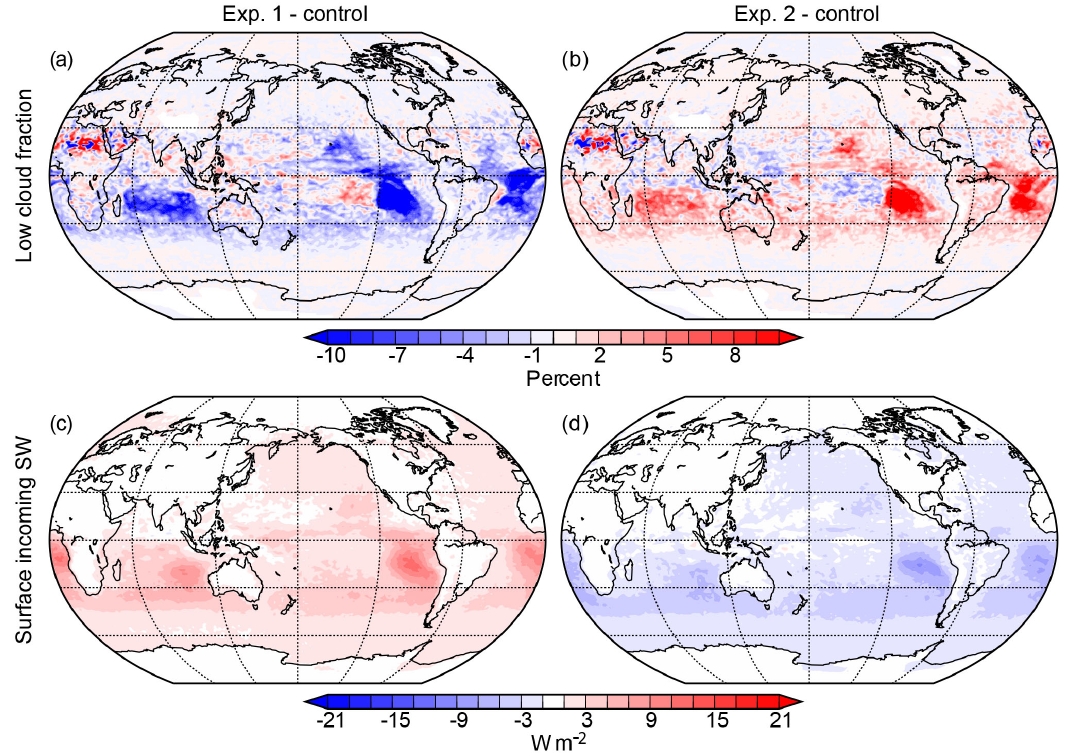
Figure 10. Comparisons of the (a–c) total liquid water at 1700m height ( Q cl ), (d–f) large-scale rainfall and (g–i) convective rainfall over the 2000–2009 period. The Ctl absolute values are shown in the first column, and respectively Exp.1 and Exp.2 minus the Ctl in the second and third columns. Units are in kgkg − 1 and mmyr − 1